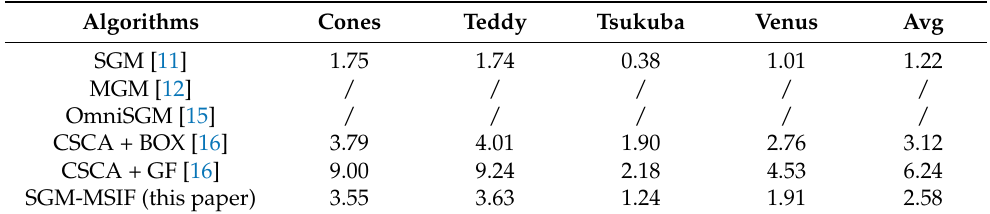
Table 5. Comparison of the running time of four algorithms (s). “/”: the results are not available